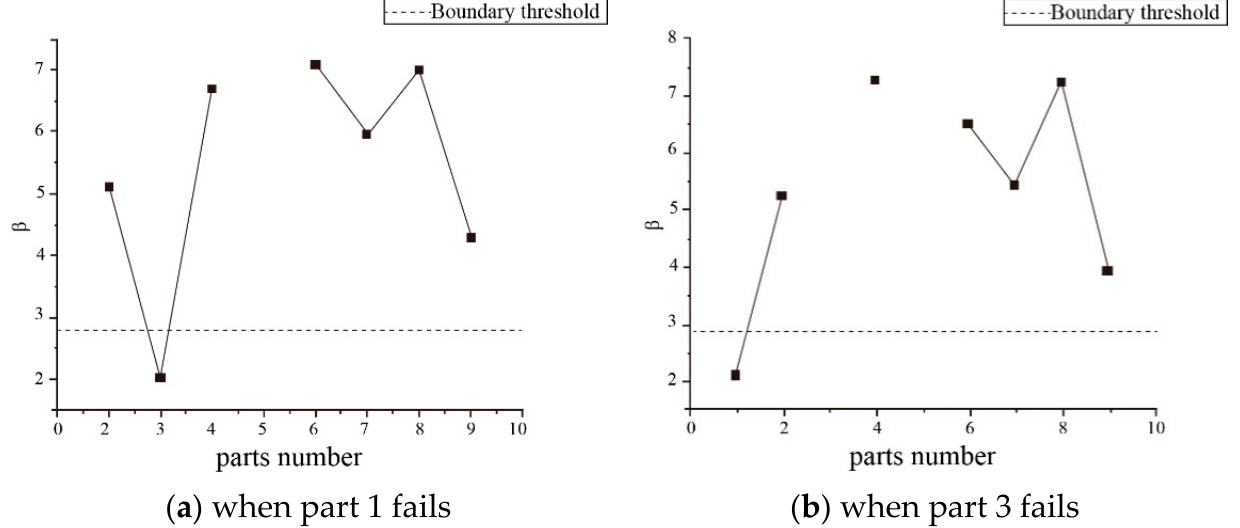
Figure 7. Reliability index at the third stage of the failure process.